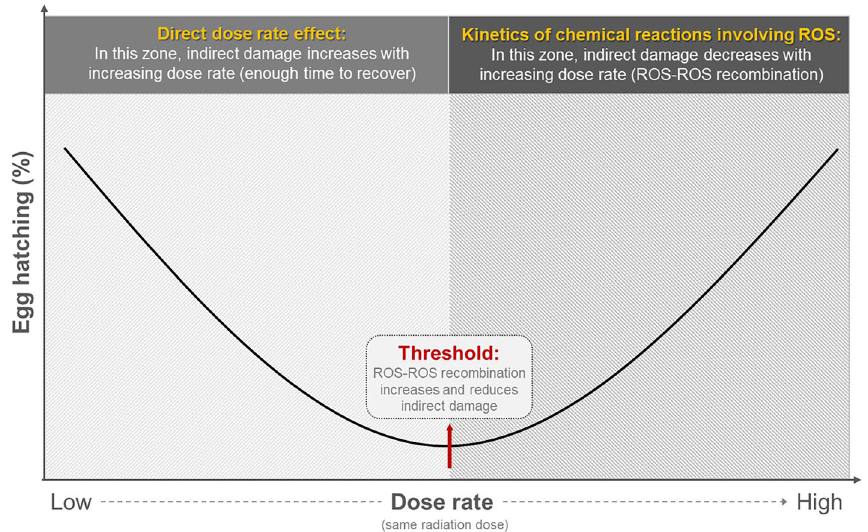
Figure 4. Illustration of the hypothesis for an indirect radiation effects influenced by dose rate, and the differential damage/repair